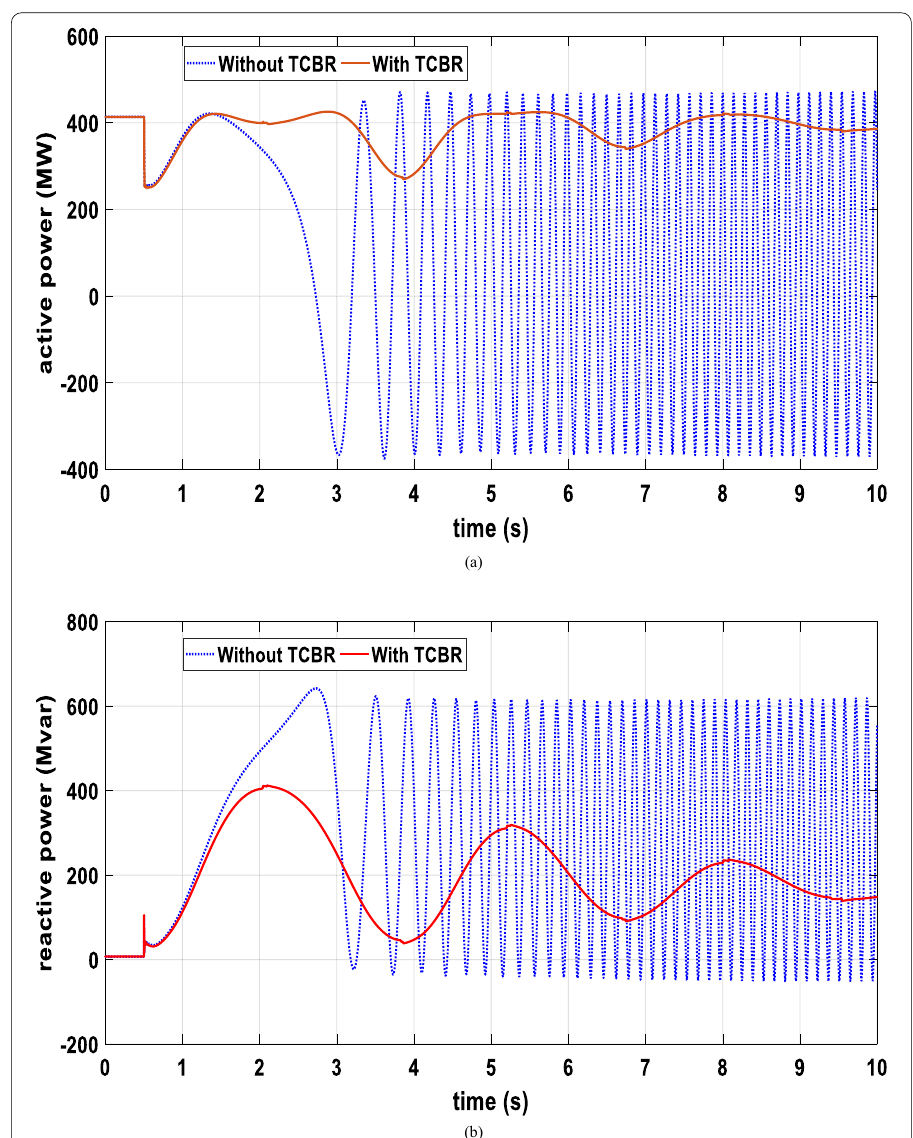
Fig. 11 Power flow responses due to line switching with and without dynamic brake, a inter‑area active power flow, b inter‑area reactive power